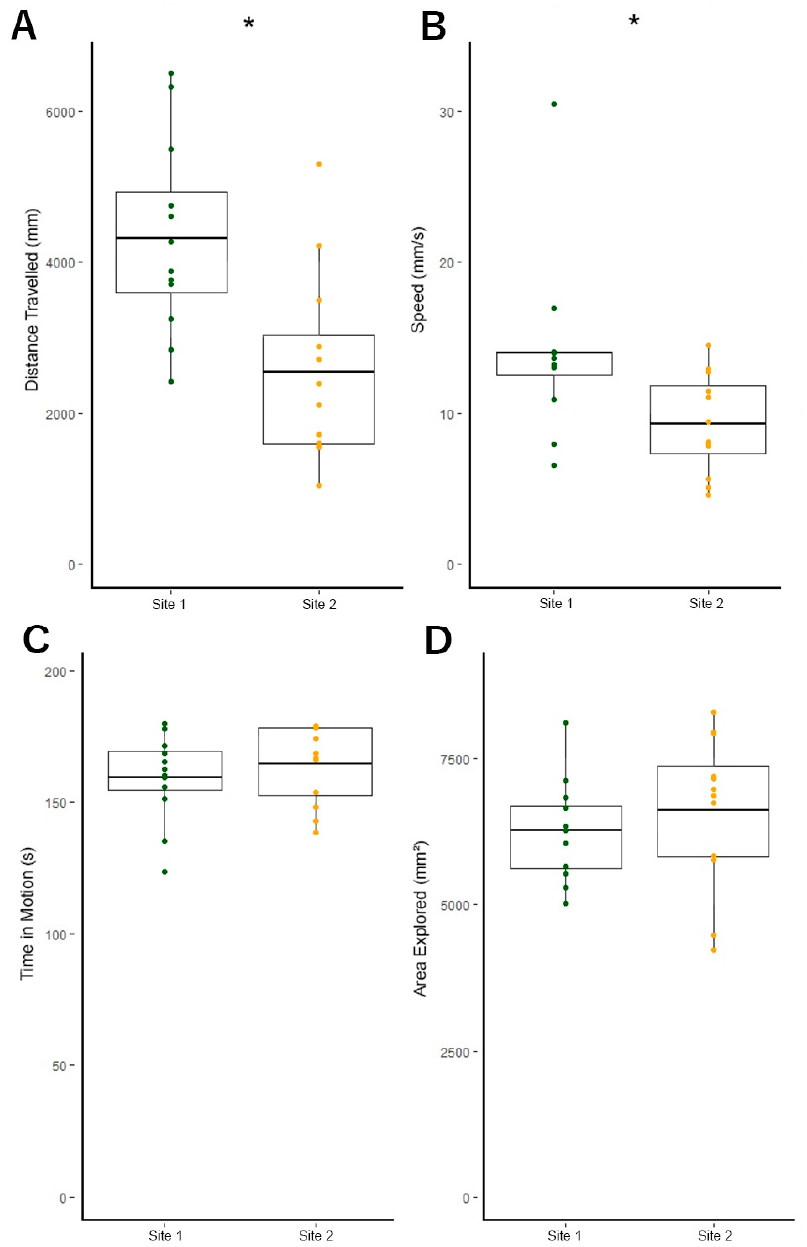
Figure 5. Site 1 fish swam faster and further, but fish from both populations maintained similar time in motion and exploration. ( A ) Fish from Site 1 swam significantly greater distances than fish from Site 2. ( B ) Fish from Site 1 exhibited significantly greater average swimming speeds than Site 2. ( C ) Fish from each population spent a similar amount of time in motion throughout the sample period. ( D ) Fish from each population explored a similar number of areas within the testing arena and thus did not differ significantly in exploratory behavior. Individual samples are overlaid onto boxplots. Boxplots denote means and interquartile range. Error bars indicate the range of scores. * p < 0.05. All data analyzed with independent samples t ‐ tests.